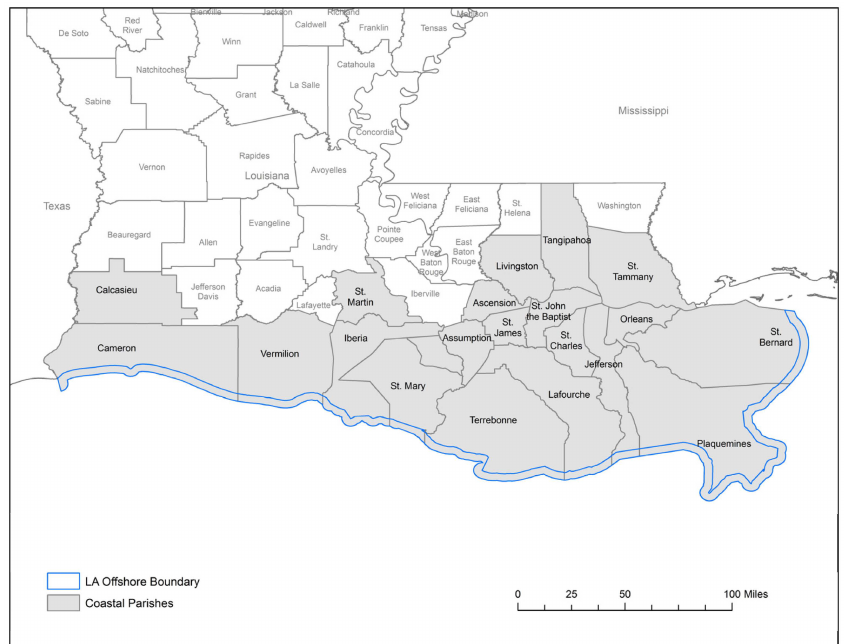
Figure 1. Study area: 20 coastal parishes in